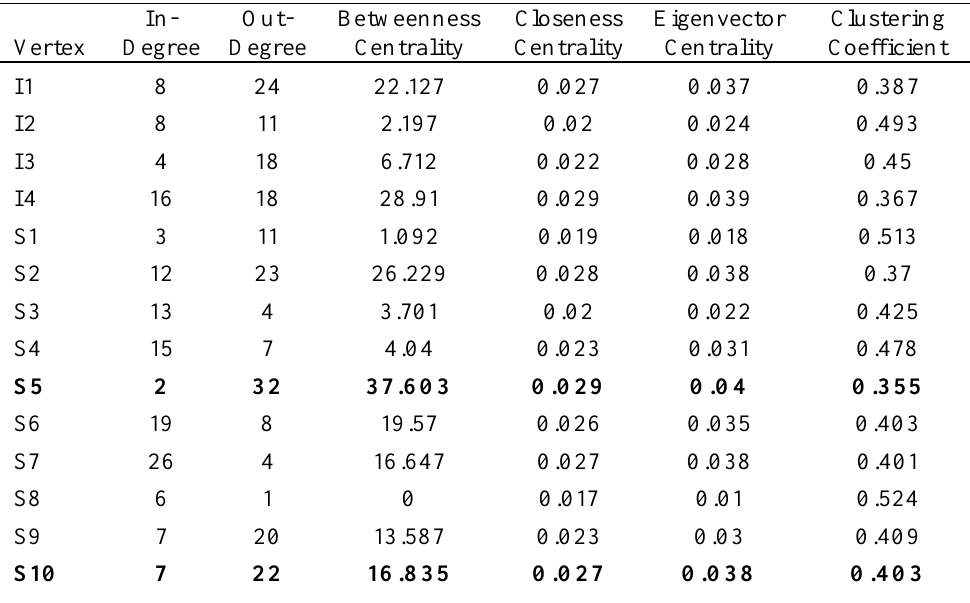
Betweeness and Closeness Centrality in the Final Four Week